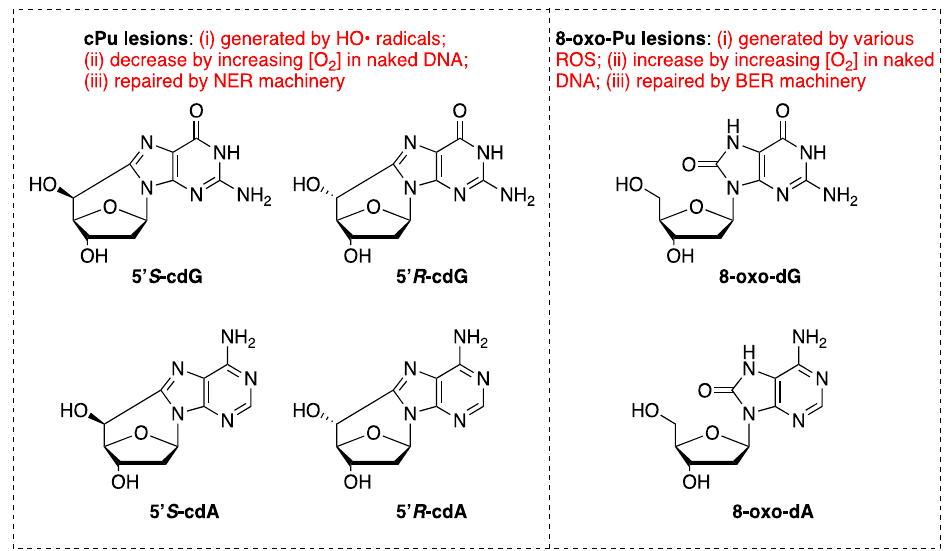
Figure A1. Left: Structures of 5 ′ ,8-cyclo-2 ′ -deoxyguanosine (cdG) and 5 ′ ,8-cyclo-2 ′ -deoxy-adenosine (cdA) in their 5 ′ R and 5 ′ S diastereomeric forms; Right: Structure of 8-oxo-2 ′ -deoxyguanosine (8-oxo-dG) and 8-oxo-2 (cid:48) -deoxyadenosine (8-oxo-dA).